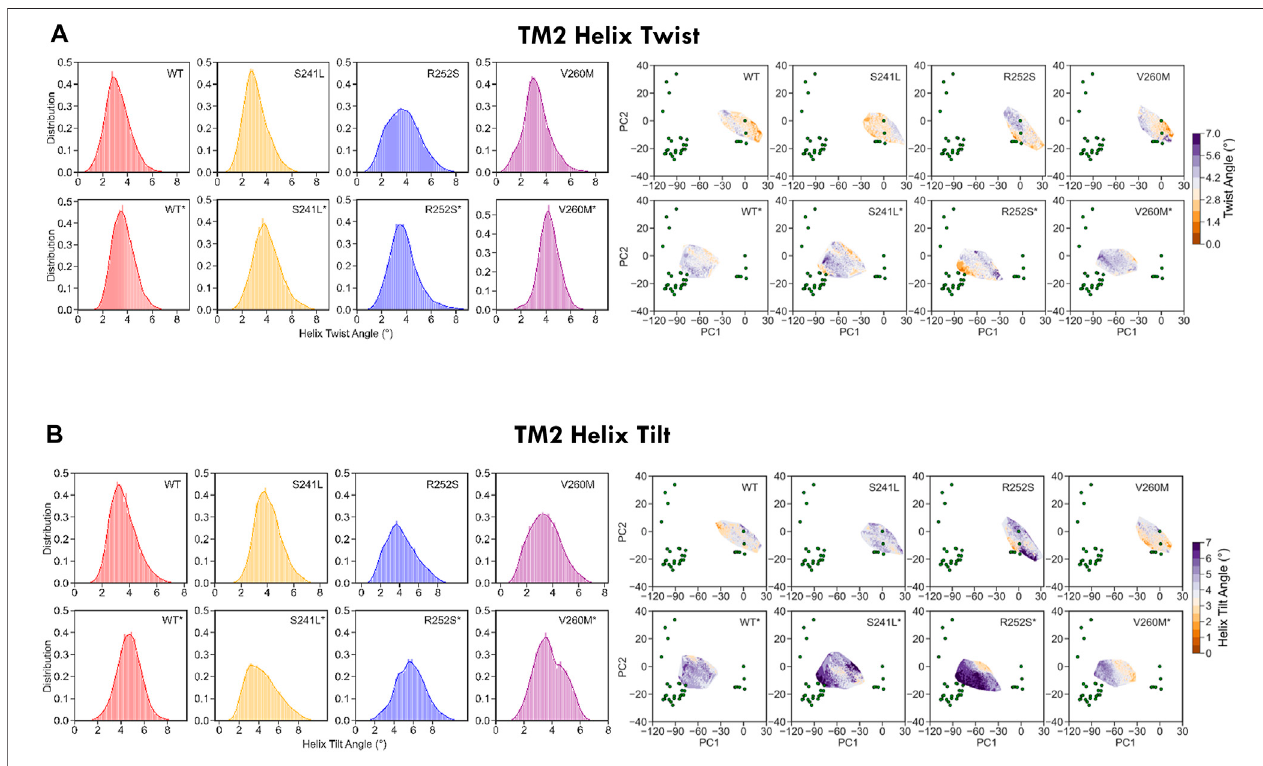
FIGURE 6 | WT and mutant GlyR local TM2 features extracted from 1.2 us meta-trajectories. (A) TM2 helix twist and (B) TM2 helix tilt. Mutations perturb not only TM2 features but also display long-range allosteric effects on ECD blooming versus WT. See average values in Supplementary Table S3 .